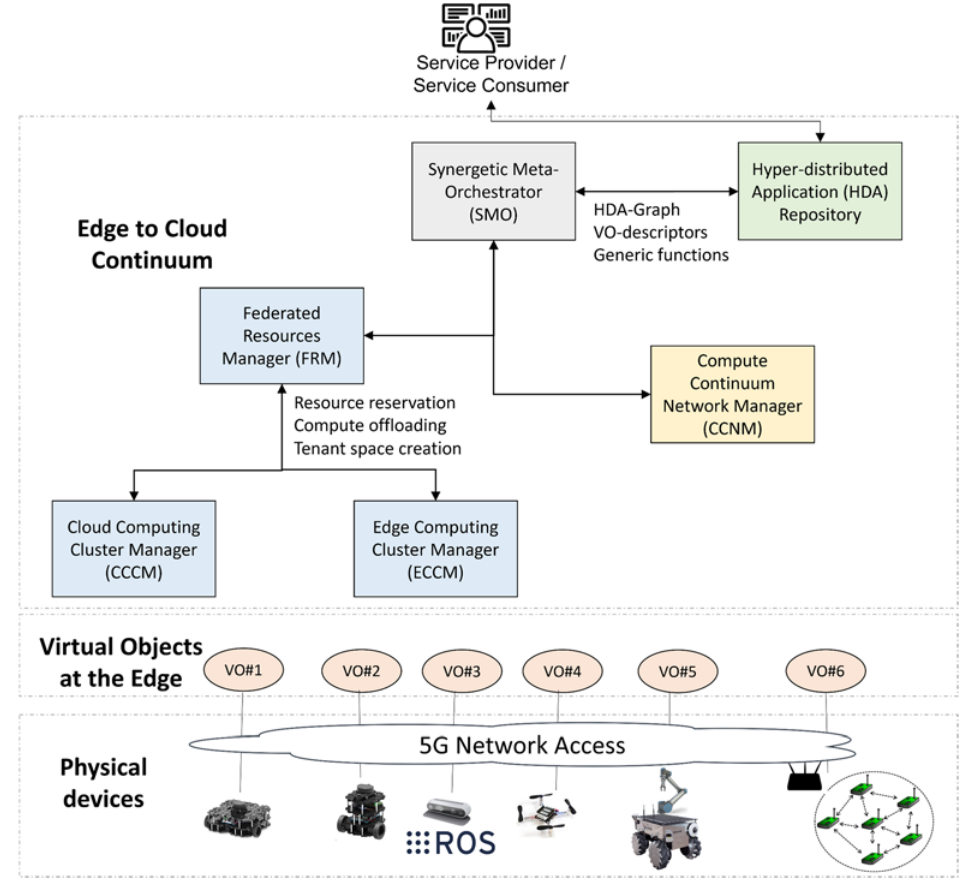
Figure 2. NEPHELE’s high-level architecture. Three layers are foreseen: a physical devices layer, with all the IoT devices (e.g., robots, drones, and sensors) connected over a wireless network to the platform; a virtual objects layer at the edge, with the virtual representation of the physical devices as a VO; edge-to-cloud continuum with a set of logic blocks for cloud and networking resource management and the orchestration of the application components.